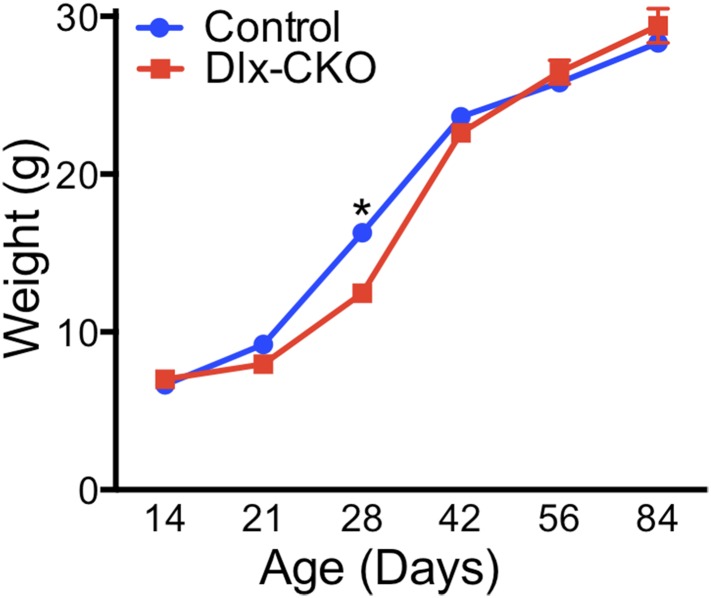
Postnatal weight gain is normal in Dlx-CKO mice.Dlx-CKO mice exhibit normal postnatal growth, minor differences in weight after weaning, and no differences after maturation (two-way ANOVA main effect of age F5,230 = 1022, p < 0.0001; genotype F1,230 = 7.903, p = 0.005; interaction F5,230 = 9.76, p < 0.0001; Sidak's multiple comparisons test).